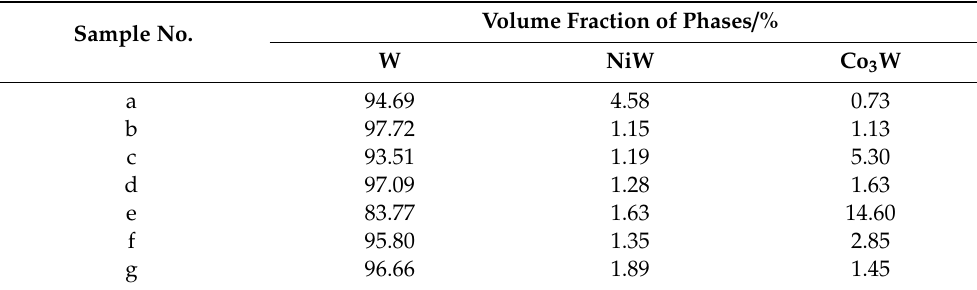
Figure 4. XRD patterns of the W-6Ni-4Co alloys by the di ff erent sintering processes. Table 3. Volume fraction of W, NiW and Co 3 W